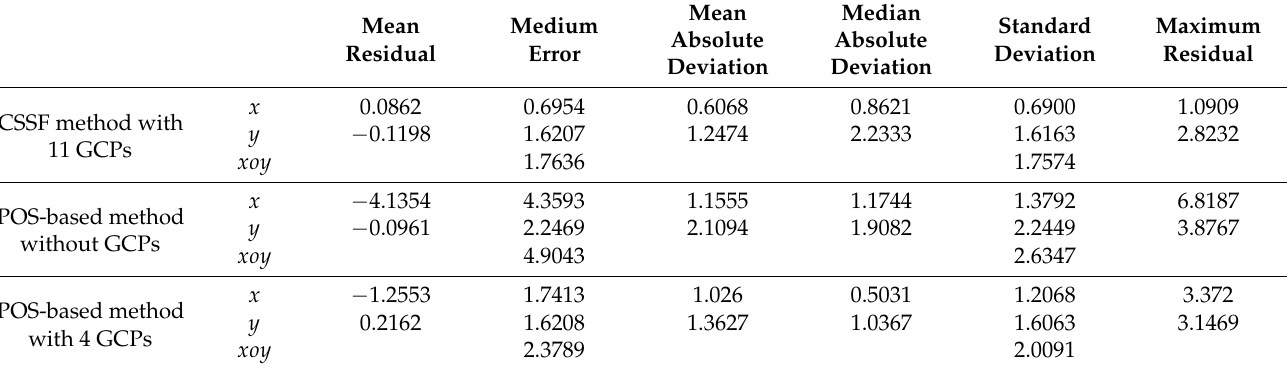
Table 3. Geometric rectification accuracy (units in meters) of the river course area.